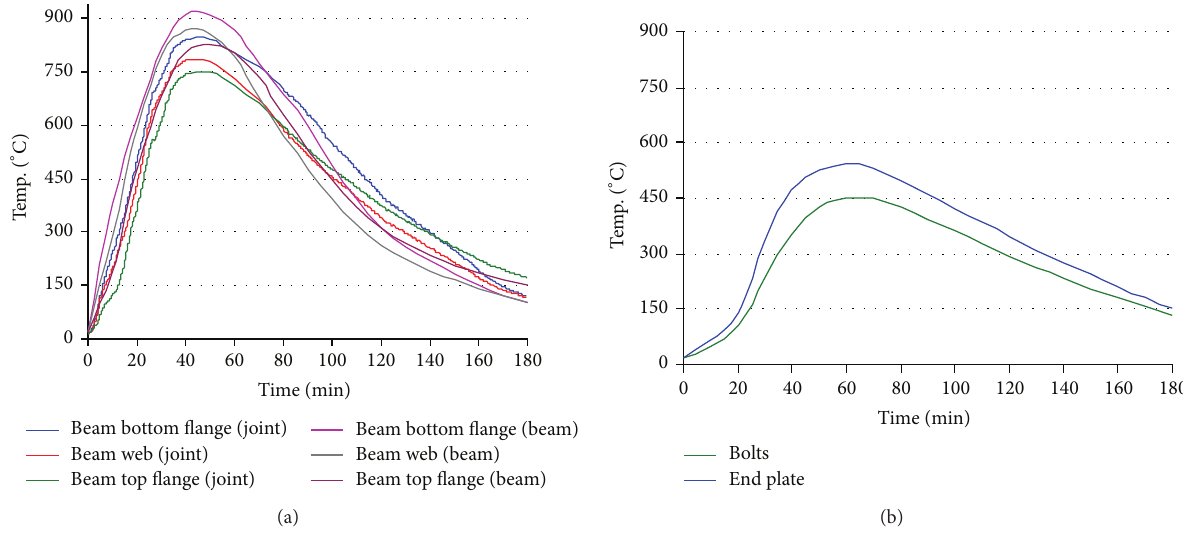
Figure 5: Range of heat application: (a) beam section; (b) joint region [8].